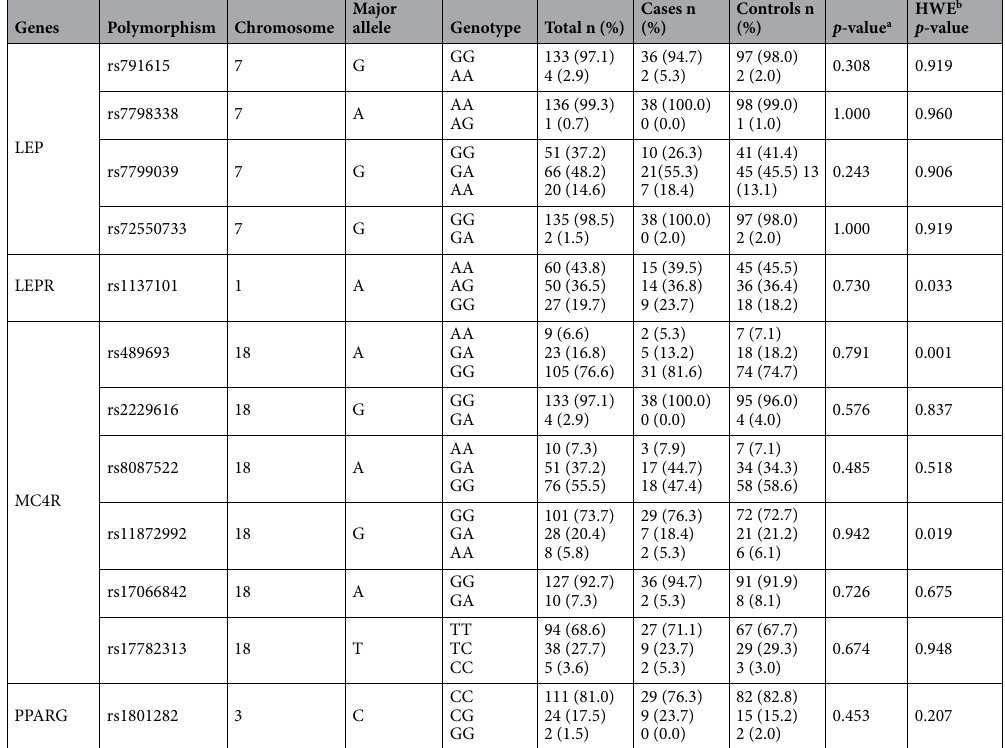
Table 3. Genotypic and allelic frequencies of certain polymorphisms in patients treated with antipsychotics. a p -value (2-sided) Monte Carlo method (10.000 samples) for 2 × 3 tables or Fisher exact test for 2 × 2 tables. b Hardy-Weinberg equilibrium (HWE) for the control group. c An indel SNP was detected (rs1799732). d For the genotype association analysis of the variants in this gene, males have been considered as homozygous females which precludes Hardy–Weinberg equilibrium. HWE was calculated only for women.